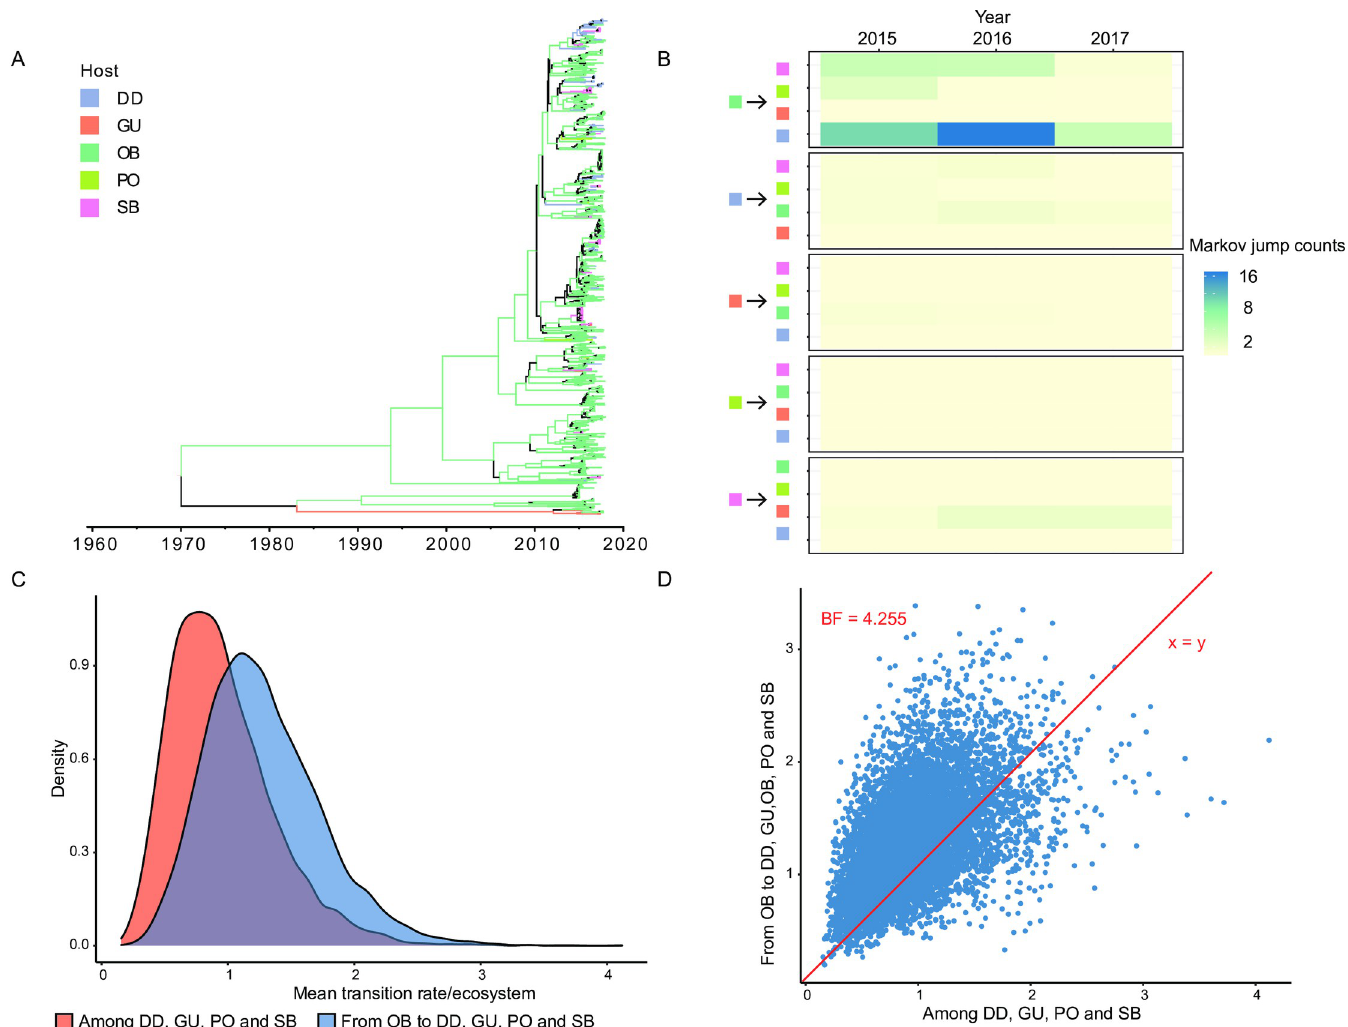
Fig 4. PB2 gene segment phylogenetic tree and Markov jumps. Bayesian phylogenetic tree (Panel A), heat map inferred number of Markov jumps among hosts groups (Panel B), plot of estimates for transitions from the other North American wild bird host group to northern Atlantic Flyway host groups as compared to strictly among northern Atlantic Flyway host groups (Panel C), and plot of ratios of posterior odds versus prior odds to infer differences in migration rate estimates between the other North American wild bird host group and northern Atlantic Flyway host groups as compared to strictly among northern Atlantic Flyway host groups (Panel D) for the PB2 gene segment. Comparable information for other 7 gene segments is provided in S2 File. Entire phylogenetic trees (e.g., Panel A) are provided in S4 File as PDFs and S5 File as TreeTaxa plots. Abbreviations for hosts groups are as follows: DD = northern Atlantic Flyway dabbling duck, SB = northern Atlantic Flyway shorebird, GU = northern Atlantic Flyway gull, PO = northern Atlantic Flyway poultry, and OB = other North American wild birds.